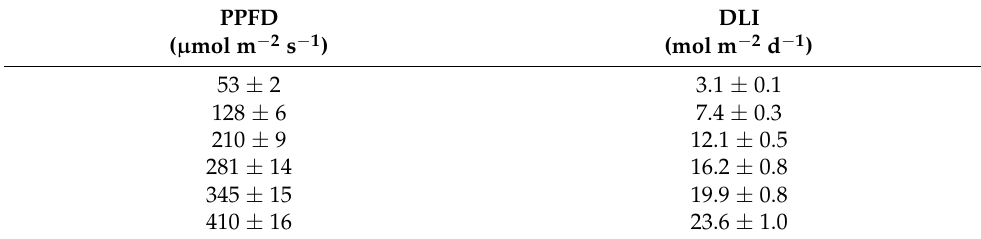
Table 1. Photosynthetic photon flux densities (PPFD), and the average daily light integral (DLI) at the center of the tray of each treatment. The photoperiod was 16 hours for all the treatments. Values show the mean ± standard